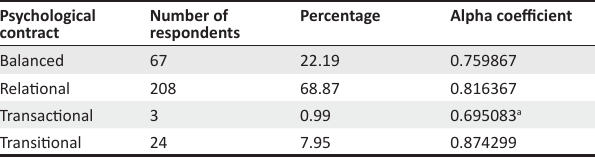
TABLE 6: Types of psychological